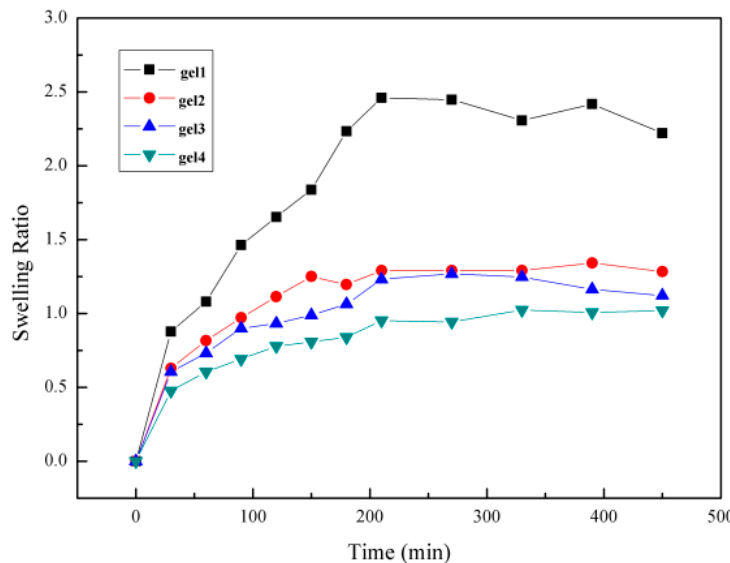
Figure 10. The swelling kinetics of gel at 25 °C.